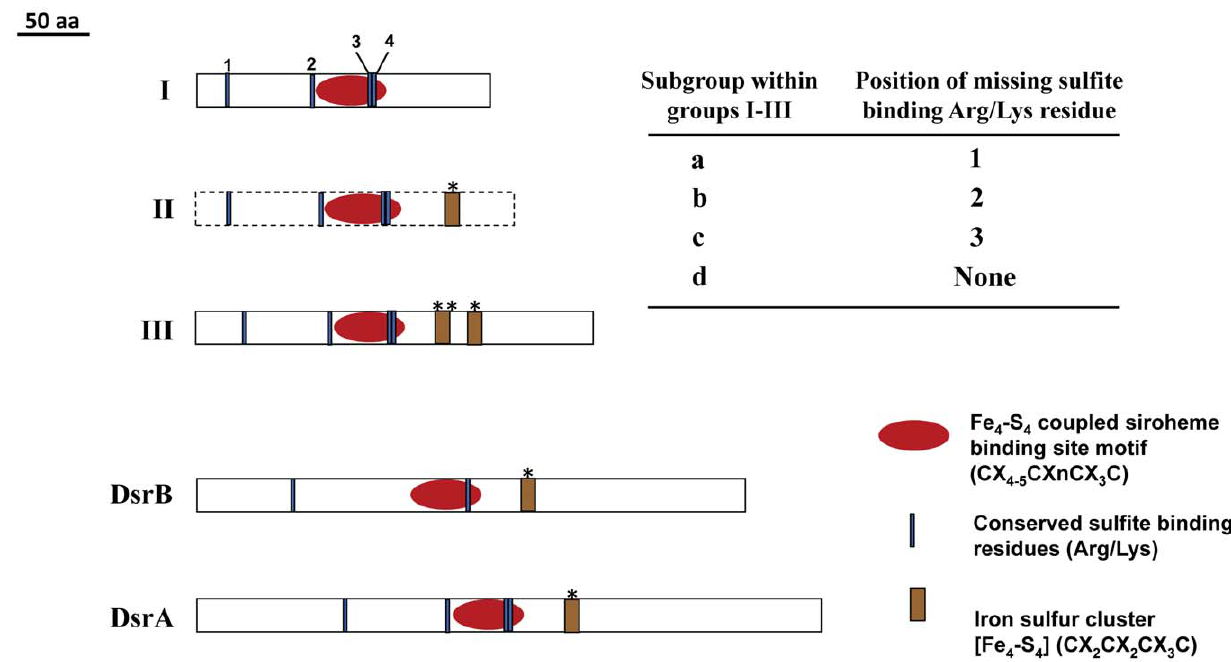
Figure 3. Groups of Dsr-LP and Dsr. The Dsr-LP classification (groups Ia-d and IIIa-d) is based on the presence and absence of the following functionally important sequence signatures: [Fe 4 -S 4 ]-coupled siroheme binding site; iron sulfur cluster sites (*, peripheral; ** additional); and sulfite binding amino acid residues (Arg or Lys). Numbers 1–4 indicates the positions (1 st , 2 nd , 3 rd and 4 th ) of sulfite binding amino acid residues. The amino acid sequences representing these characteristics are shown in Fig. S1. Groups IIa-d, represented by dotted-line box are hypothetical and yet to be detected.